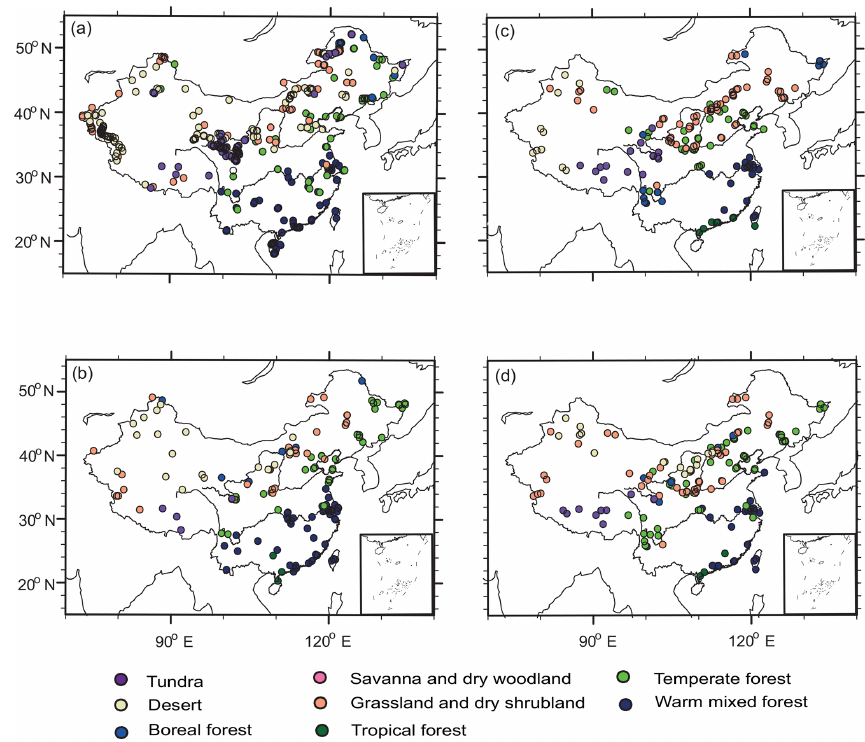
Figure 2. Comparison of megabiomes for PI (a, c) and the MH (b, d) : (a, b) BIOME6000 and (c, d) pollen data collected in this